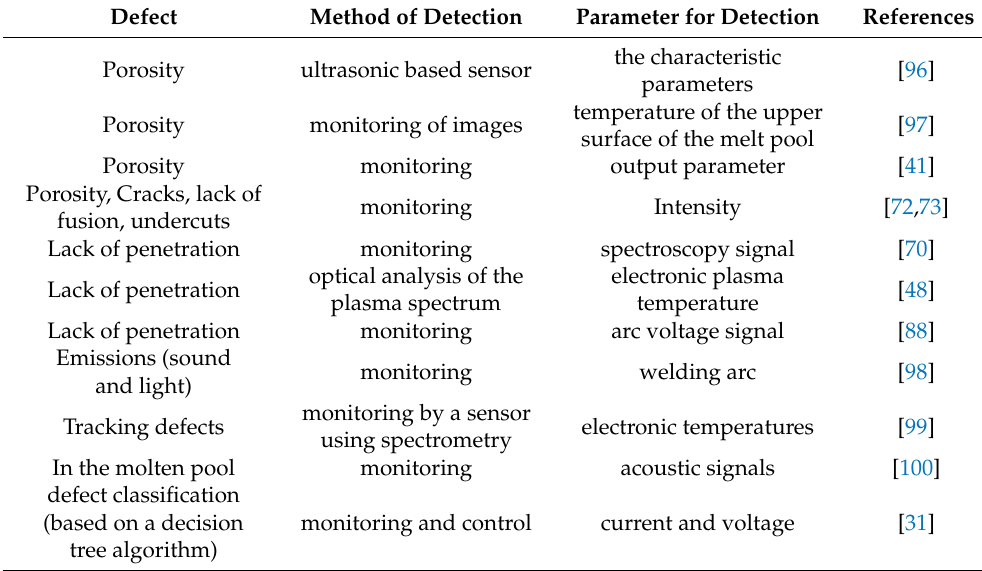
Table 2. Different methods of defect detection through process